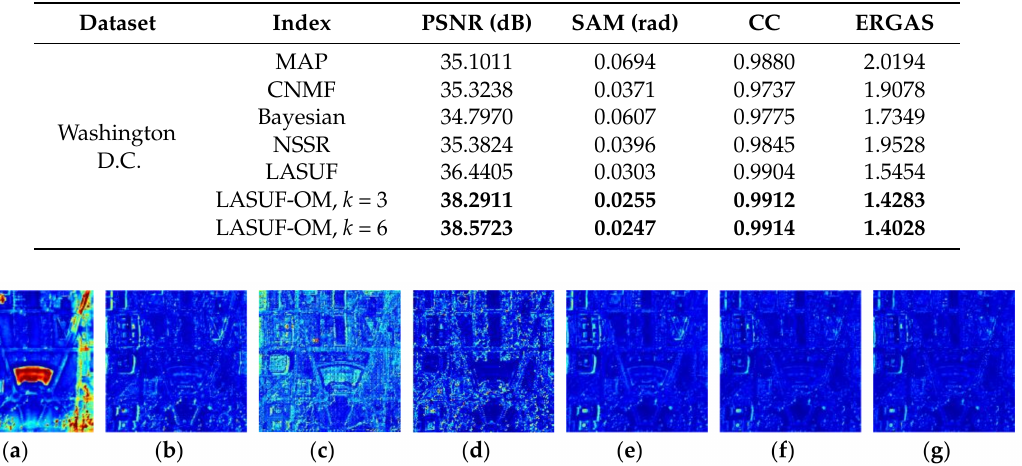
Figure 13. SAM maps of the enhanced images for Washington D.C. dataset. (1/3 subpixel shift): ( a ) MAP; ( b ) CNMF; ( c ) Bayesian; ( d ) NSSR; ( e ) LASUF; ( f ) LASUF-OM, k = 3; ( g ) LASUF-OM, k =